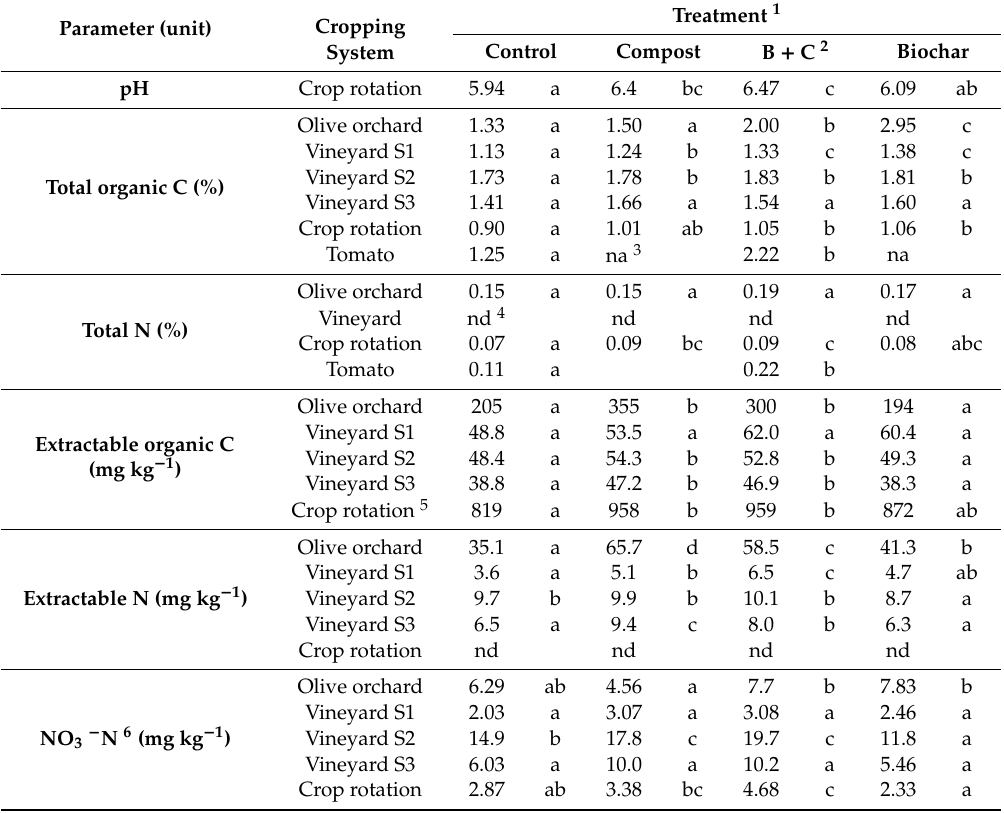
Table 3. Soil fertility parameters after three years of field scale experiments for di ff erent cropping